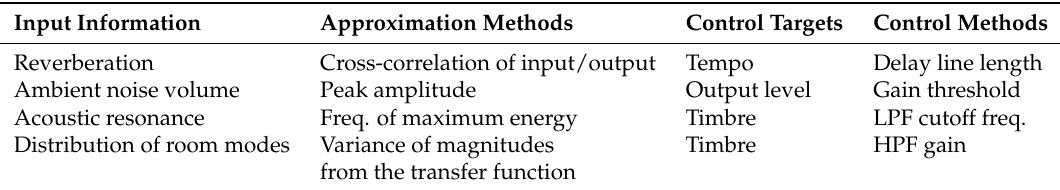
Table 1. Comparison of input information, approximation methods, control targets and methods for composition of musical tendencies depending on information carried in the feedback signals regarding the acoustic